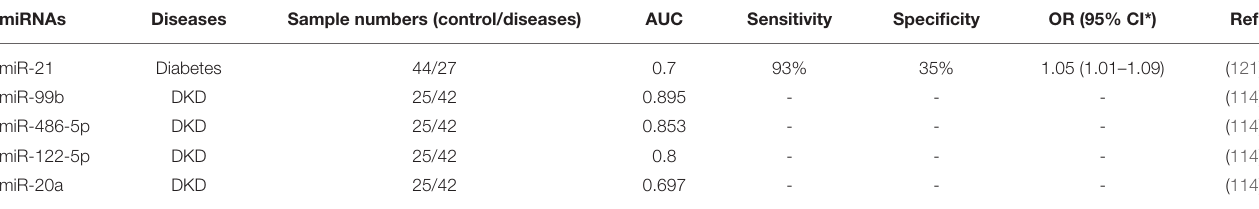
TABLE 1 | Diagnostic index of miRNA in human DM-related OS.